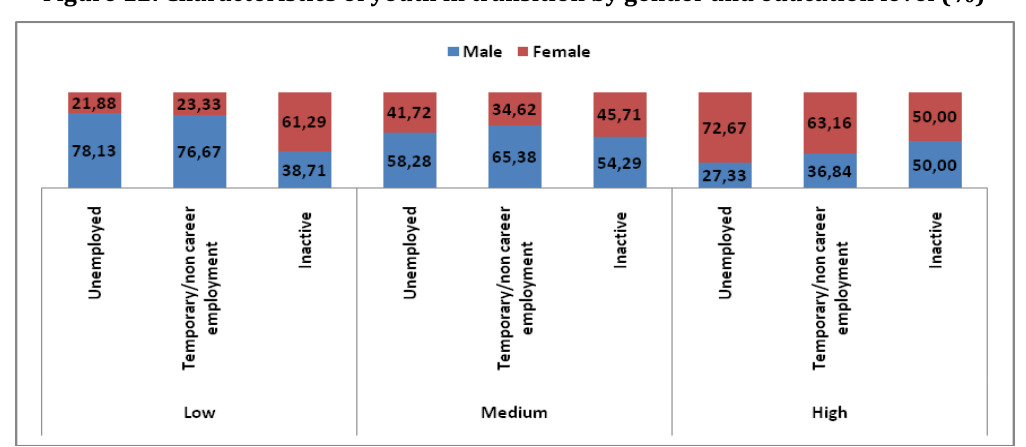
Source : TLMPS 2014 and authors’ calculation